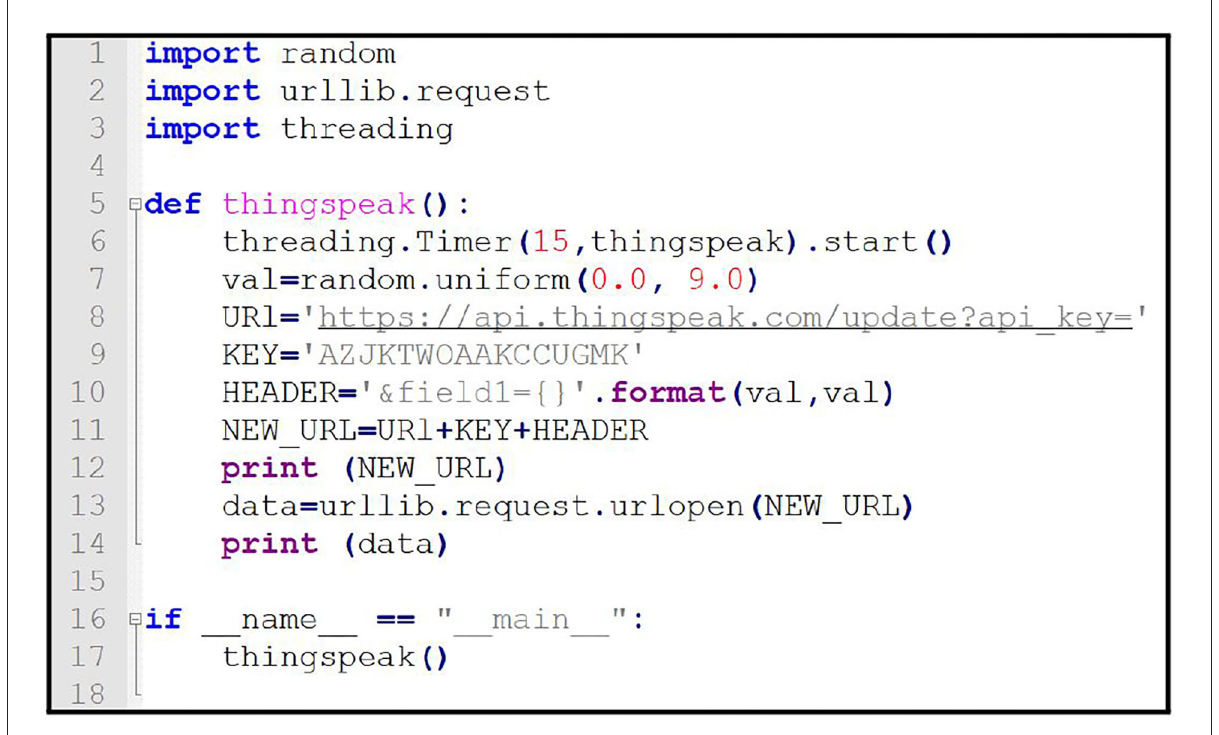
FIGURE6 Python code for the seismic agent responsible for monitoring